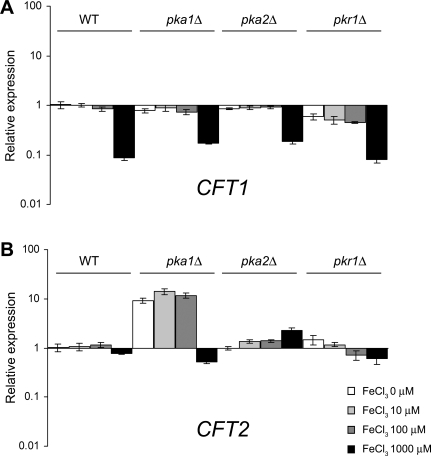
The Expression of CFT1 and CFT2 Are Regulated by Components of the cAMP-Dependent Protein KinaseStrains lacking PKA1, PKA2 or PKR1 were grown in media containing different concentrations of iron (0, 10, 100 and 1,000 μM of FeCl3), and transcript levels of CFT1 (A) or CFT2 (B) were compared by quantitative real-time RT-PCR. Data were normalized by using ACT1 as an internal control, according to the ΔΔCt method, and presented as relative expression. Data are from four replicates and bars represent the standard deviations.